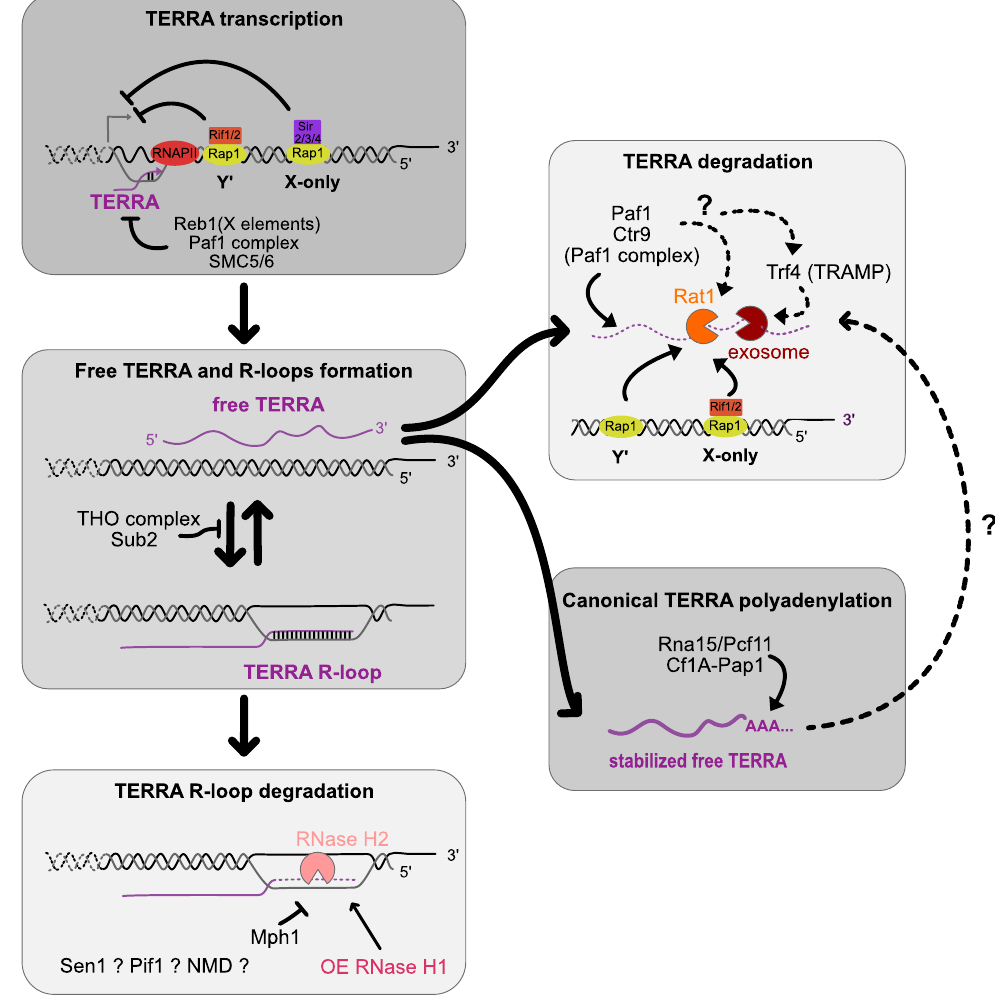
Figure 1. TERRA transcription and regulation in budding yeast. RNA polymerase II (RNAPII) transcribes TERRA from the 5' C rich telomeric strand starting in subtelomeres towards telomeric ends from both X-only and Y'- telomeres. Rap1 represses TERRA transcription by recruiting Sir2/3/4 on X-only telomeres and Rif1/2 on Y' telomeres. Reb1 binds on its binding sites residing in the X ele-